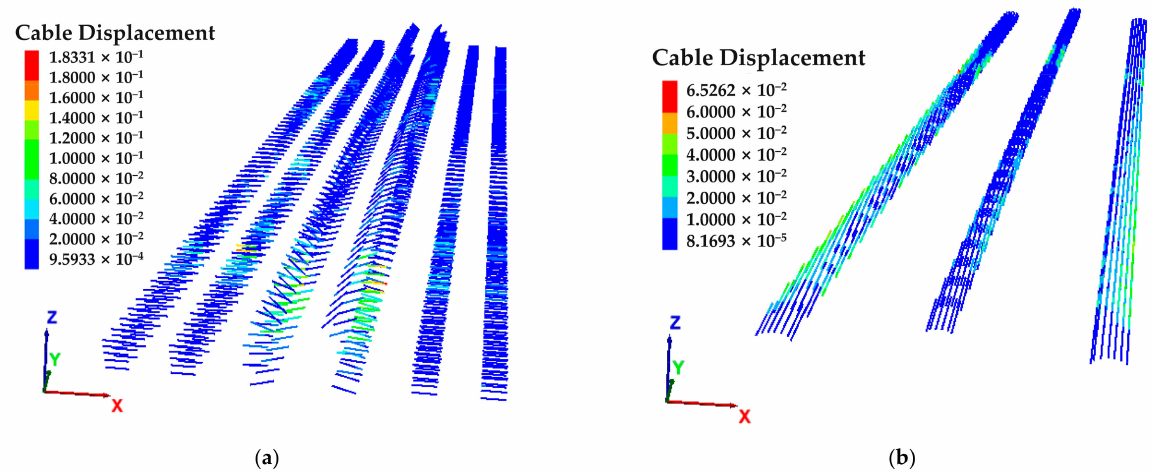
Figure 13. Deformation of supporting structure (unit: m): ( a ) Normal supporting bolt; ( b ) Advance supporting